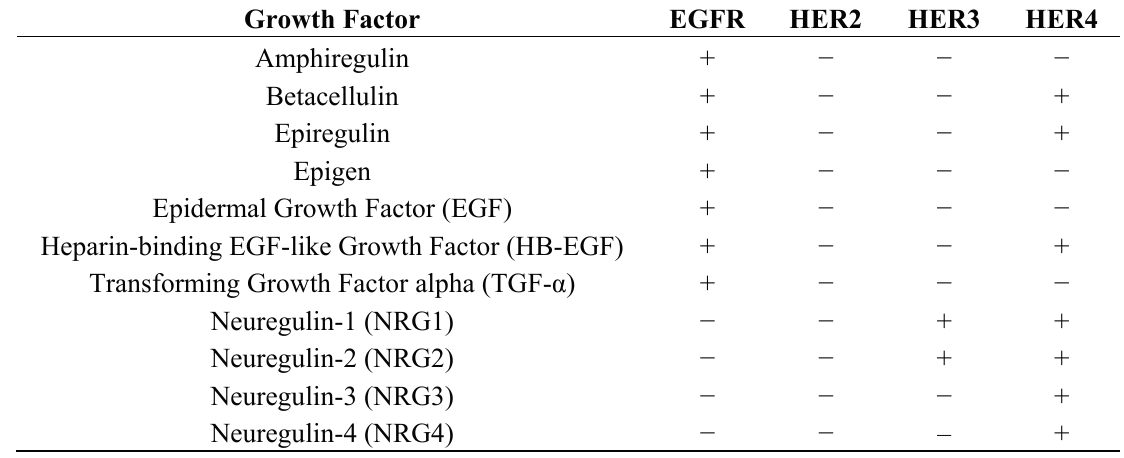
Table 1. Known growth factor ligands and their associated erbB